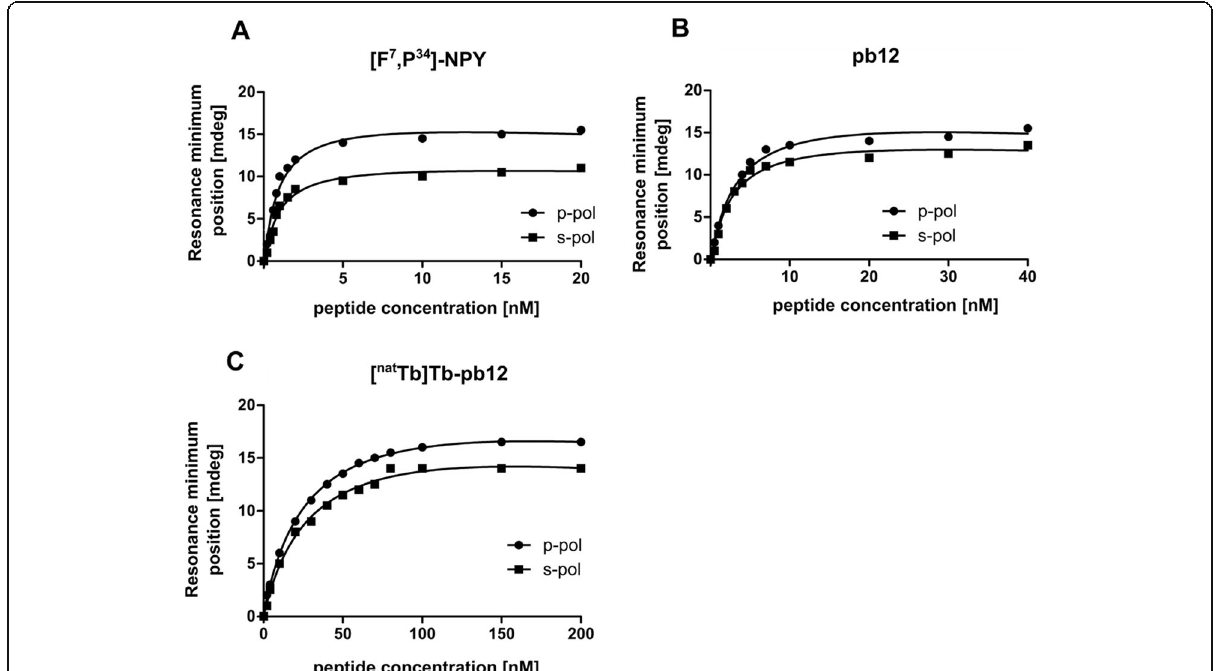
Fig. 3 Affinity of [F 7 ,P 34 ]-NPY (control, a ), pb12 ( b ), and [ nat Tb]Tb-pb12 ( c ) determined using PWR on MCF-7 cell fragments. p-pol stands for the light component that is perpendicular to the sensor surface and so the lipid membrane, and s-pol stands for the light axis component that is parallel